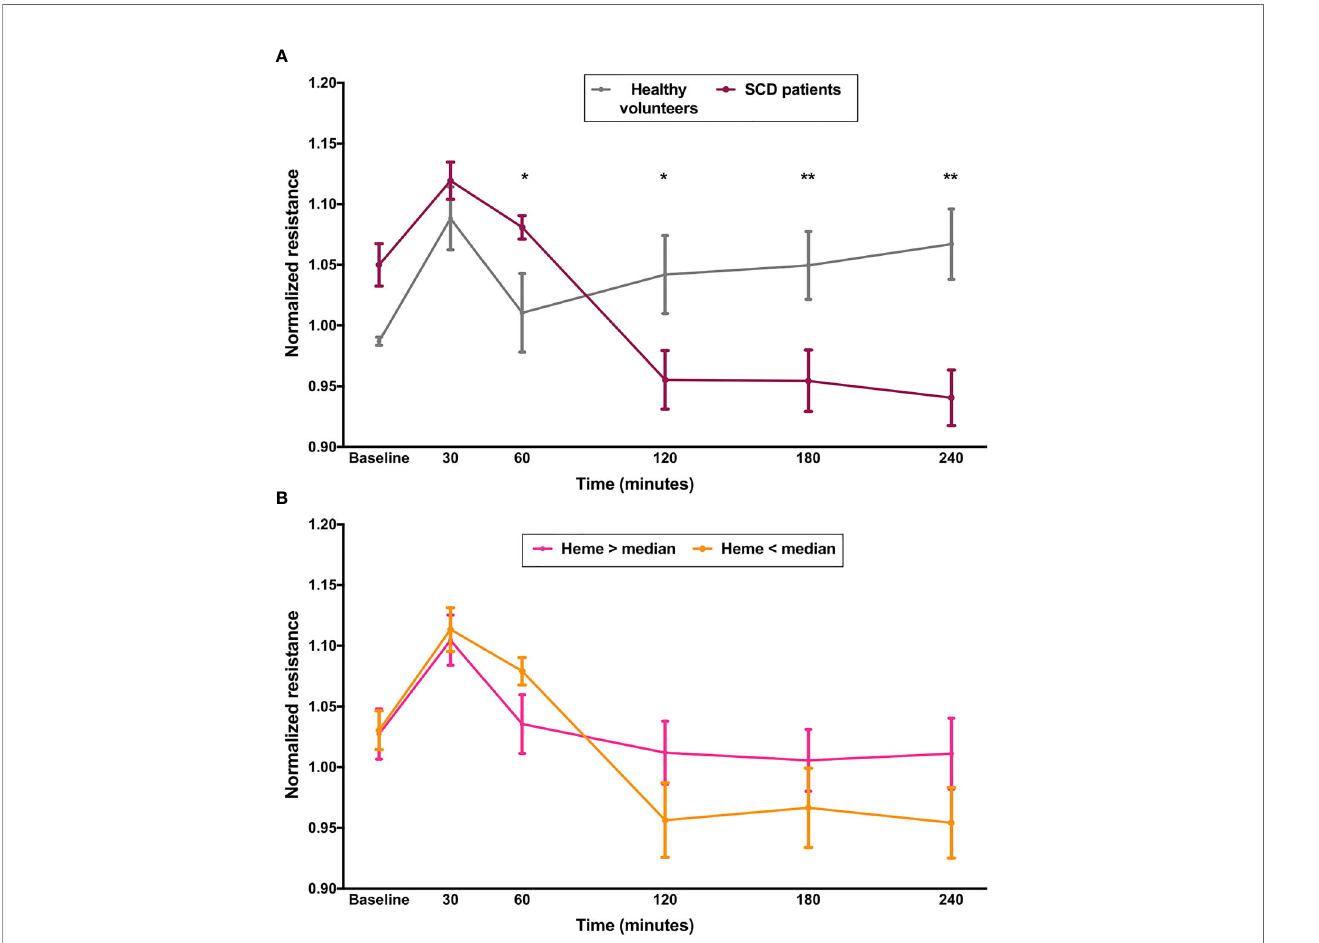
FIGURE 2 | Effect of sera from SCD on EB integrity. Con fl uent HUVEC monolayers were incubated with sera (20% v/v) from SCD patients (n=20) or healthy volunteers (n=10) and normalized resistance was recorded at 4,000 Hz. Each line represents the mean ± SEM in the speci fi ed time points from experiments comparing (A) patients and healthy volunteers; or (B) patients subgrouped by total levels of heme in serum. Differences were compared using the Mann-Whitney test. Statistical signi fi cant differences are indicated by colored asterisks on each timepoint. *P= 0.01 to 0.05;